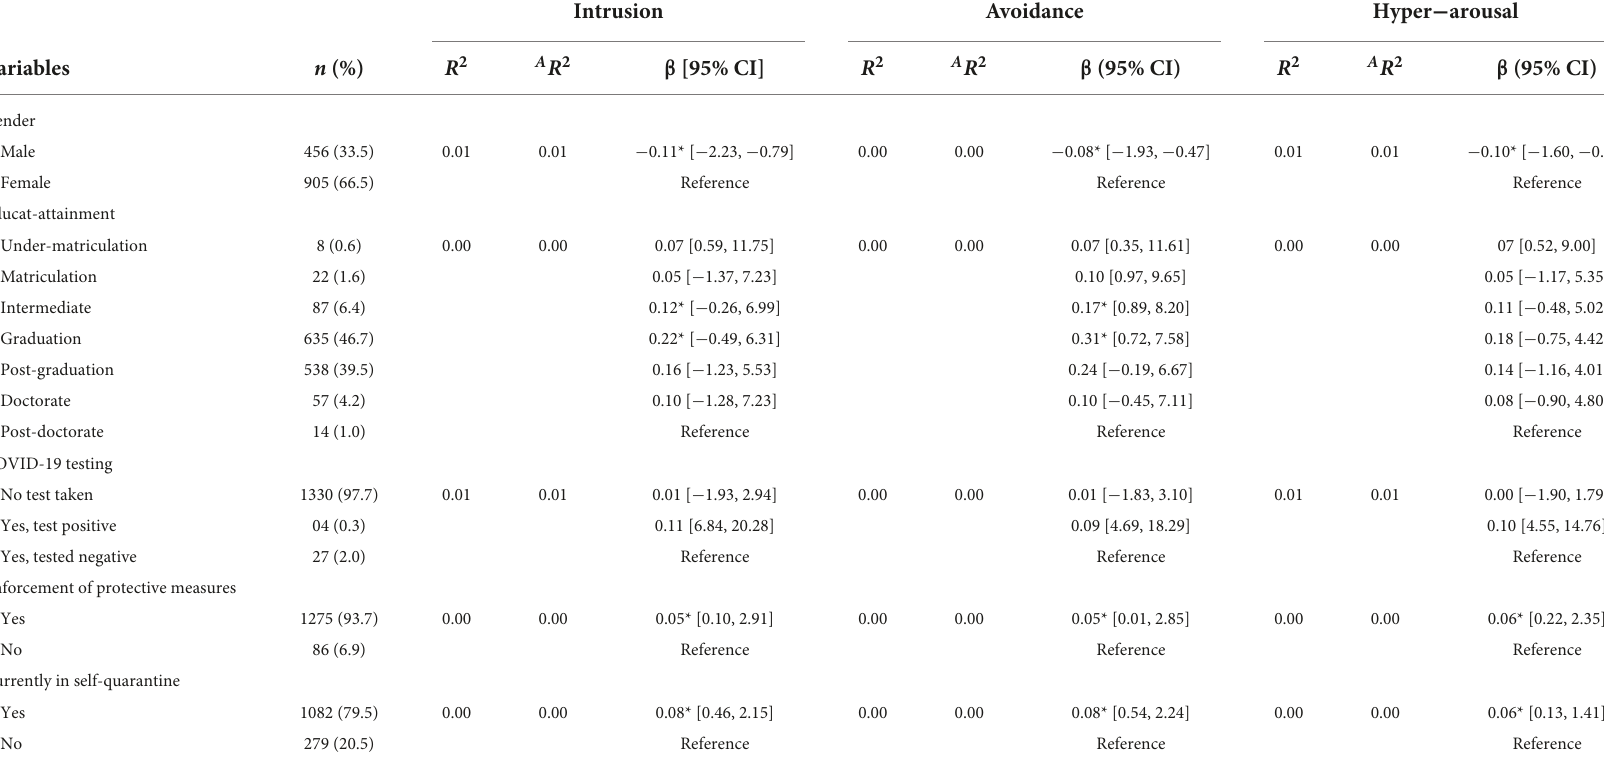
TABLE 6 Regression of associations between demographic variables and Impact of Events Scale-Revised Intrusion, Avoidance and Hyperarousal Subscales ( N = 1361). Intrusion Avoidance Hyper −